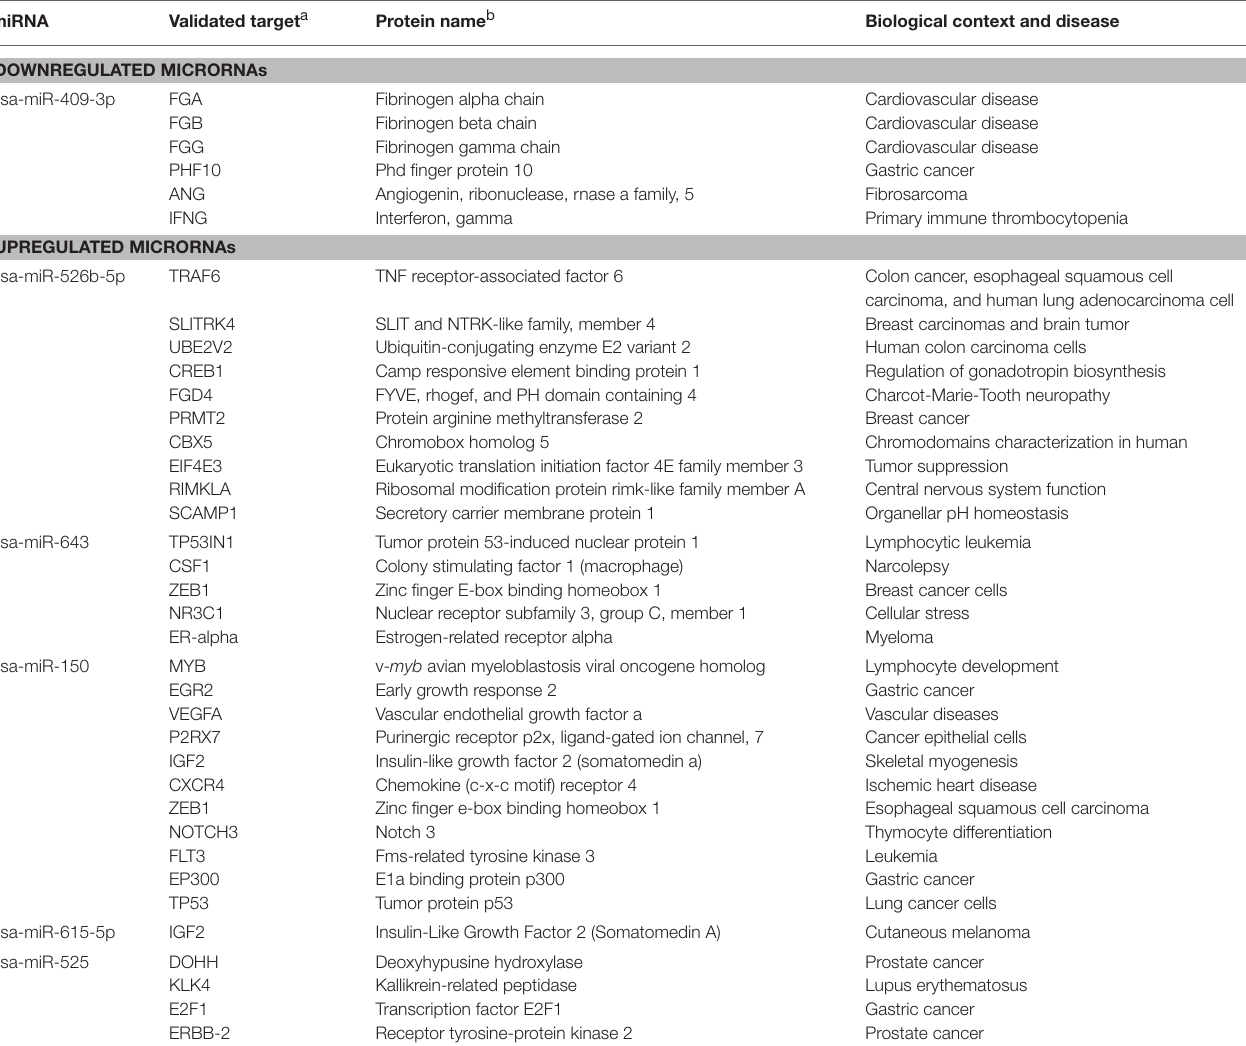
TABLE 2 | Validated targets for miRNAs regulated at 45min in SW-480 cells after interaction with E. histolytica according to miRTarBase (http://mirtarbase.mbc.nctu.edu. tw/php/index.php).